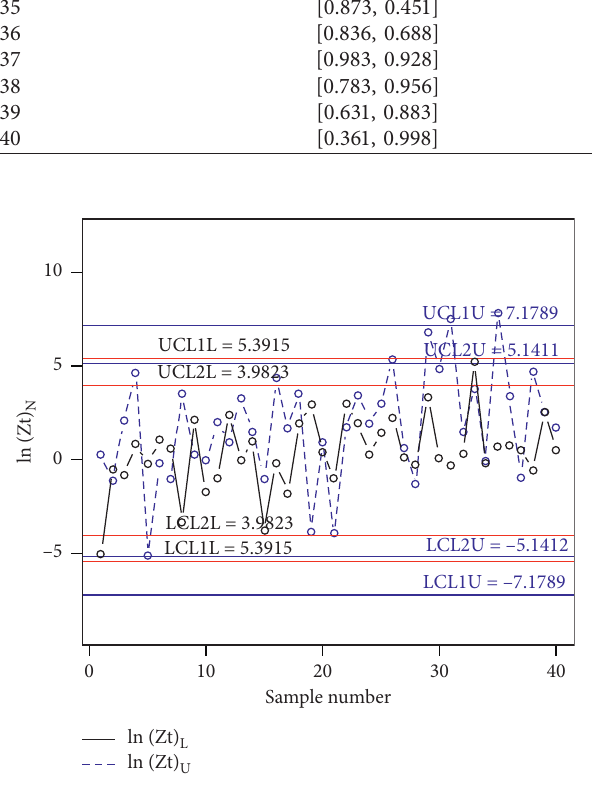
Figure 1: The proposed control chart using simulated